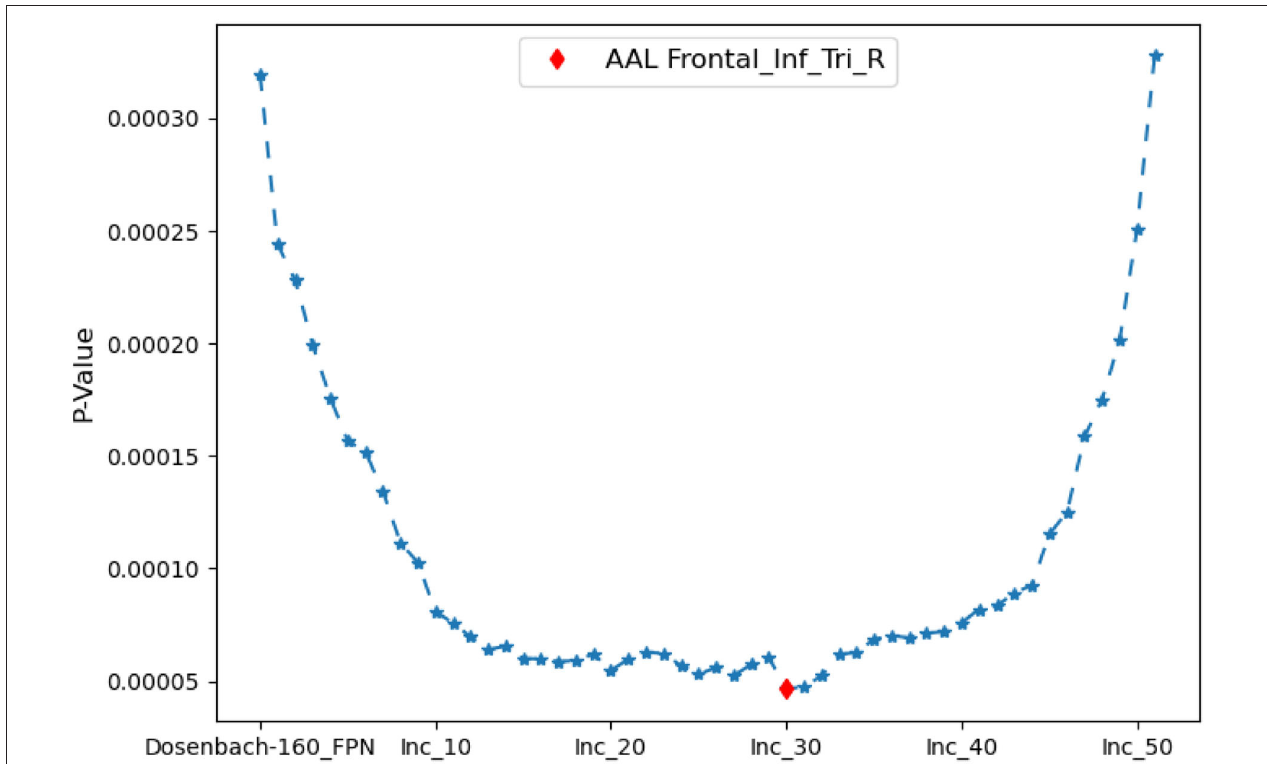
FIGURE 7 | The iterative statistical test of the graph properties of the candidate fused FPNs in discriminating the cognitive states. When Dosenbach-160 is set as the initial candidate fused FPN, and the top thirty of all ROIs in AAL, Power-264, and Willard-499 are added to Dosenbach-160, the candidate fused FPN can produce the most significant statistical performance. The last ROI to be added to the fused FPN is the triangular part of the inferior frontal gyrus from the right hemisphere of